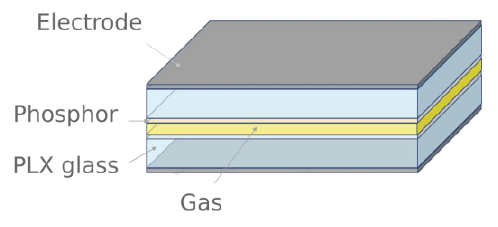
Figure 1. Planilum struct ure [9]